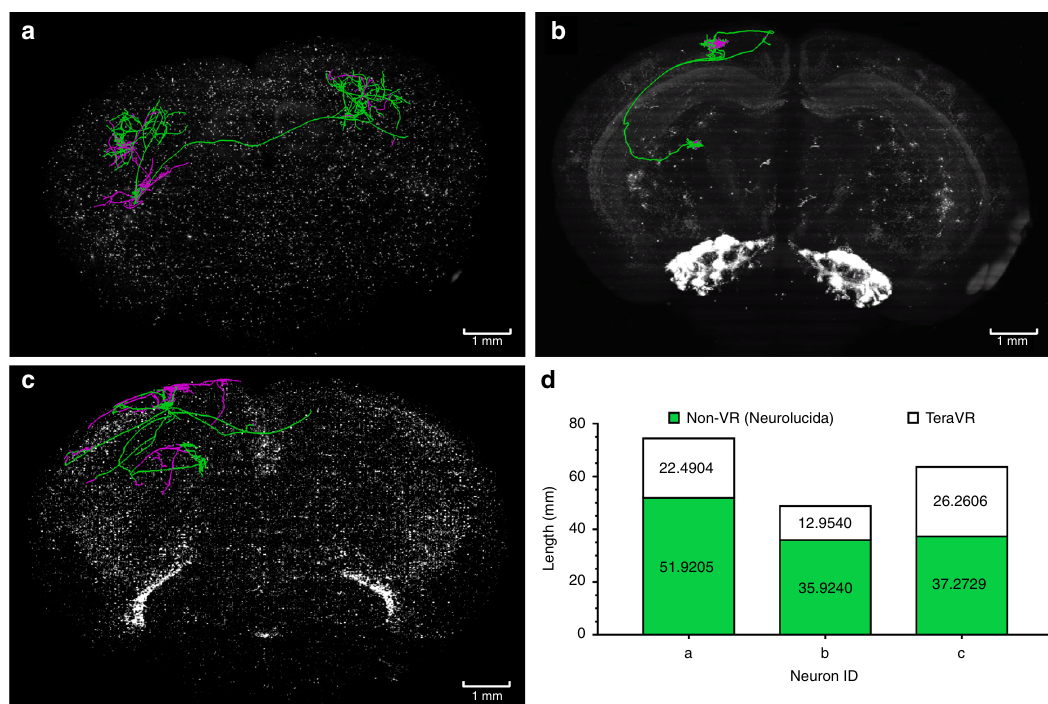
Fig. 4 The use of TeraVR in validating, correcting, and extending complex neuron reconstructions produced with Neurolucida. a – c Three examples of reconstructed neurons overlaid on the whole-mouse brain imaging data, from three different brains (brain no. 236174, 17545, 17300), respectively. Green: initial reconstructions produced using Neurolucida; magenta: recovered missing portion of reconstructions using TeraVR. d The length of neuron reconstructions produced for a – c ,